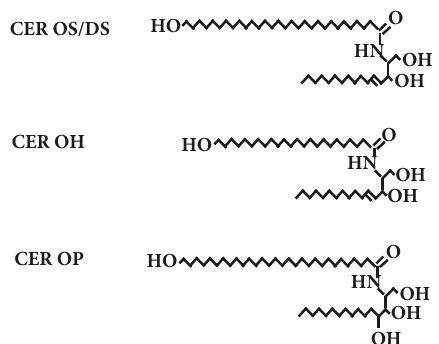
Figure 3: Structures of the covalently bound 𝜔 -hydroxyceramides from porcine (OS/DS) and human (OS/DS, OH and OP) stratum corneum [12, 17,